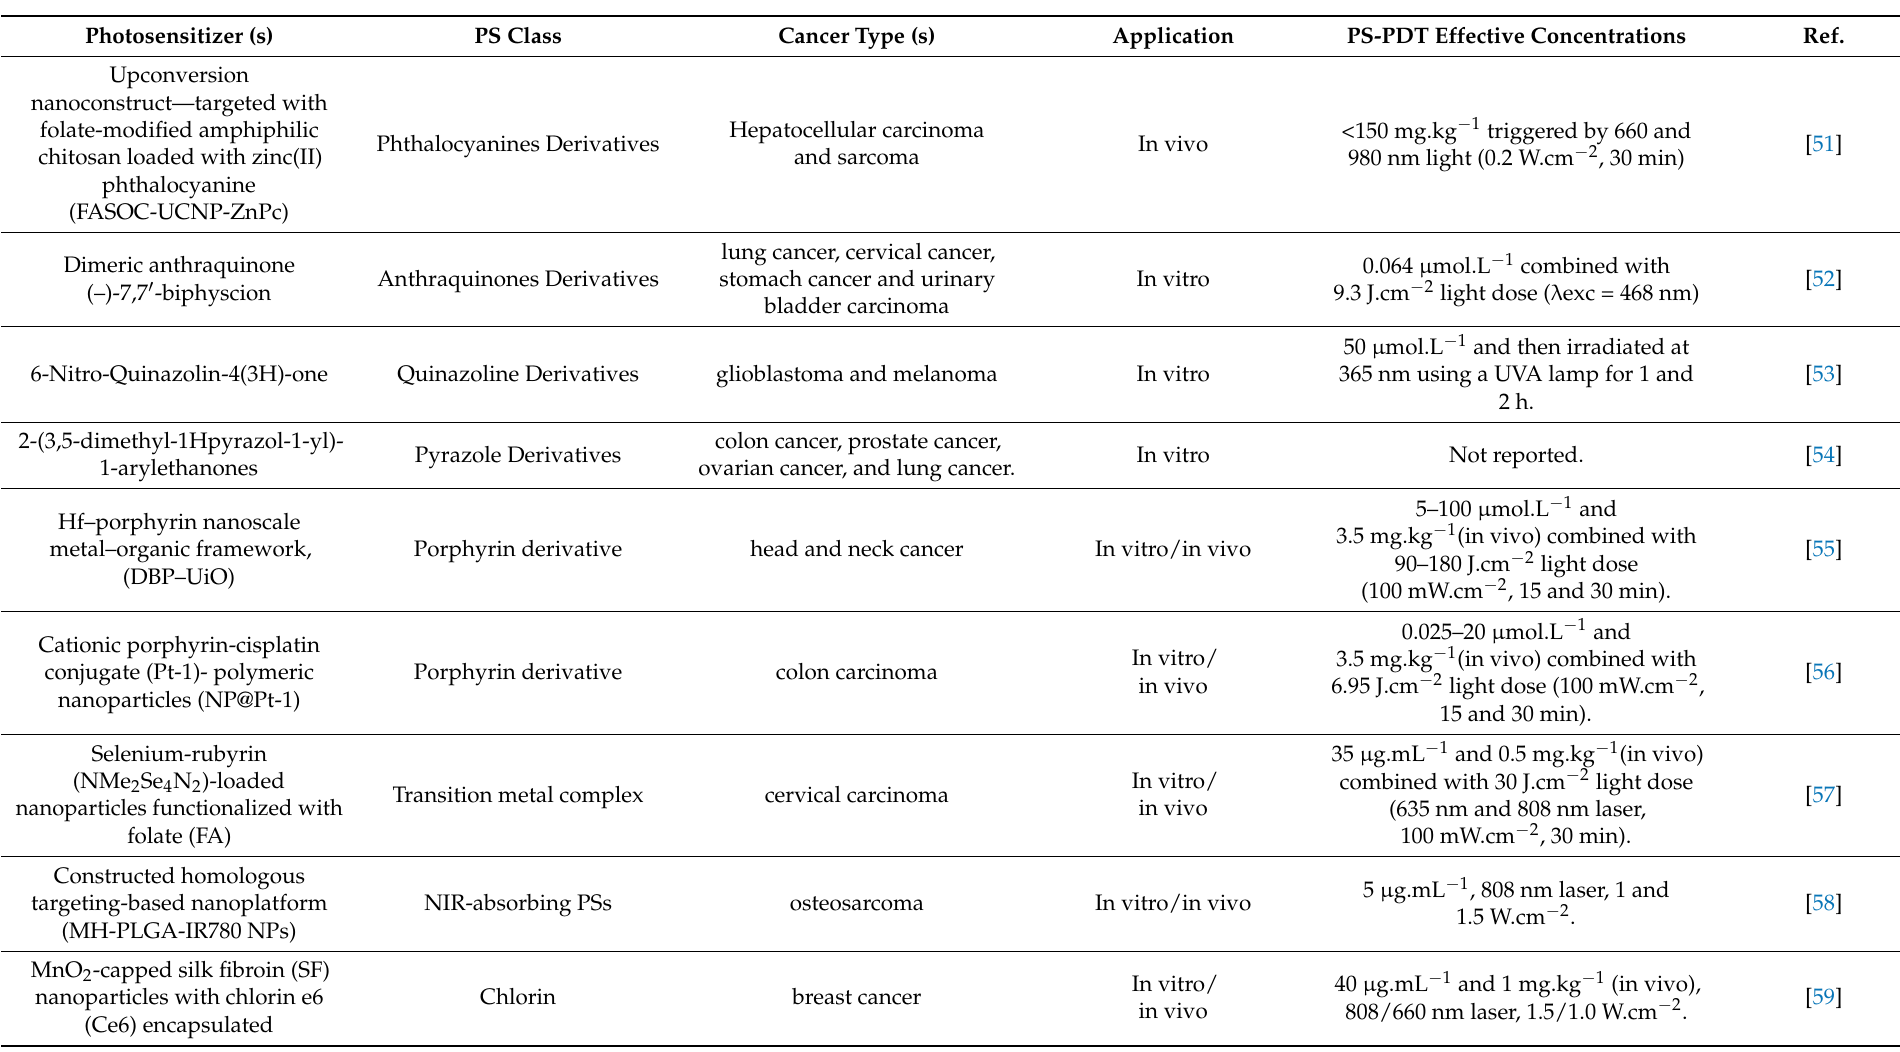
Table 1. Overview of photosensitizers used for in vitro/in vivo treatment of cancer in the last